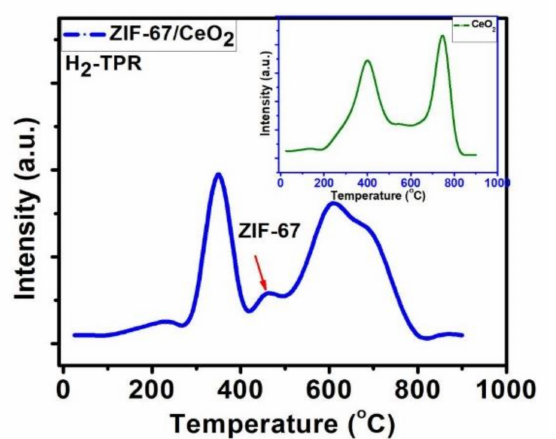
Figure 8. H 2 -TPR results of CeO 2 and ZIF-67/CeO